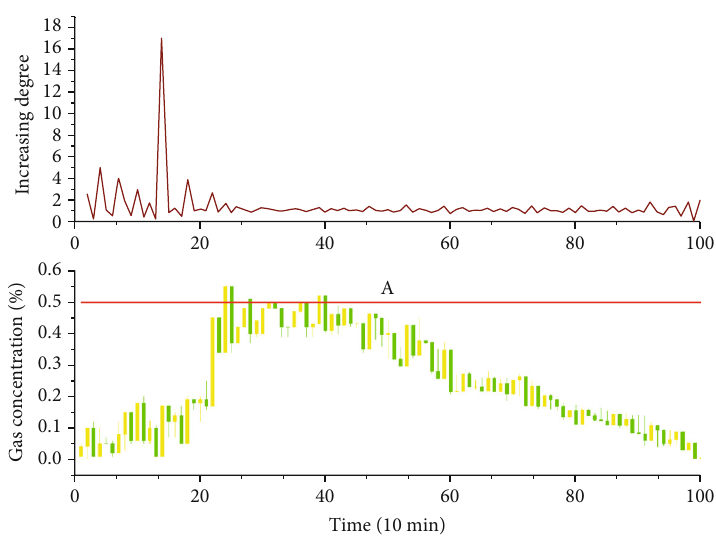
Figure 5: Increase degree of gas